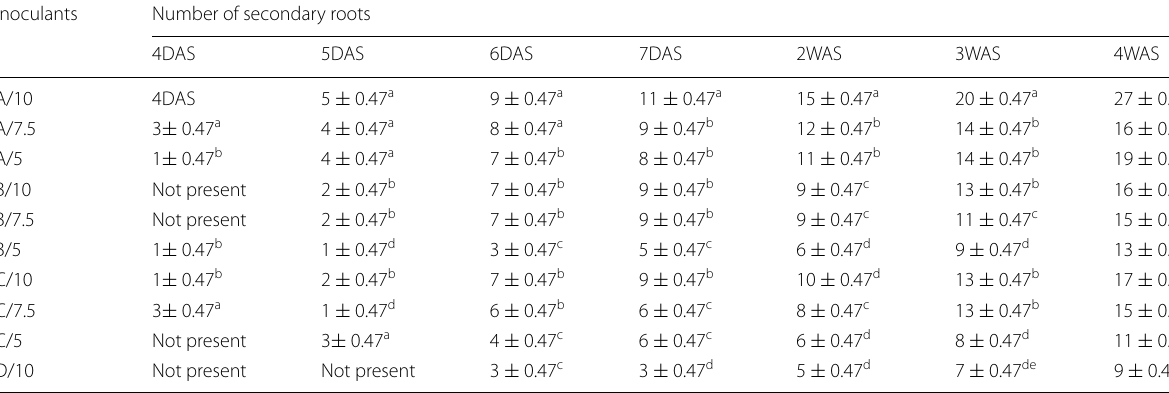
Table 7 Influence inoculum on number of secondary roots